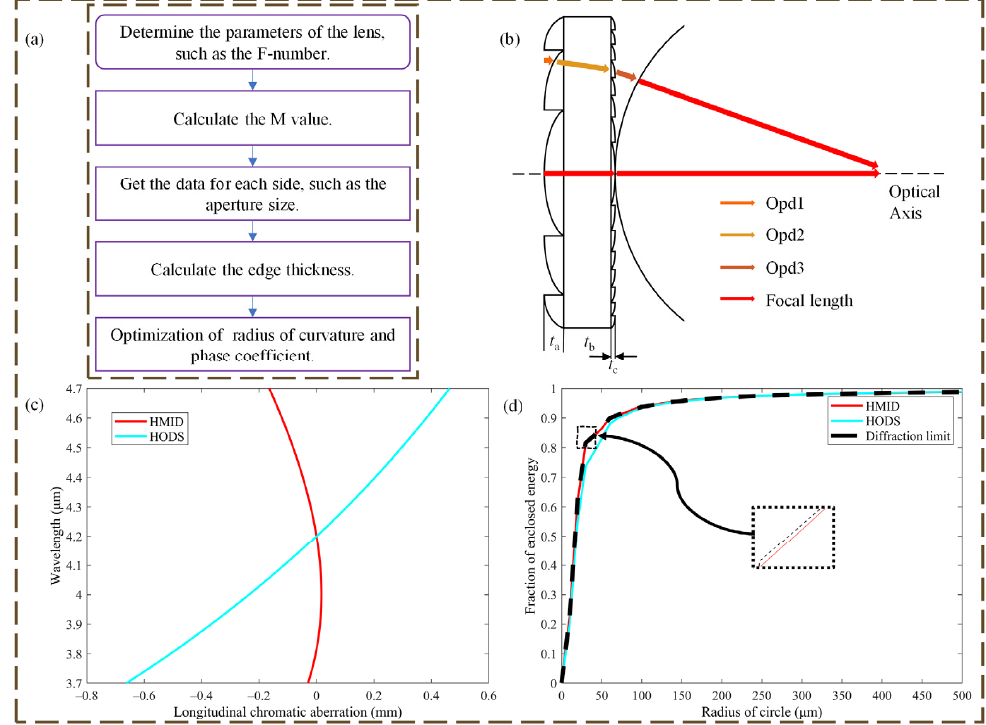
Figure 3. ( a ) Design flow chart of HMID; ( b ) Layout of HMID includes HODS with thickness t a = 0.225 mm and a t b = 4.714 mm germanium substrate with a t c = 1.39 μ m FODS on the back surface. A schematic diagram of the calculation of ray tracing is included; ( c ) LCA comparison of HMID and HODS, where the maximum reduction is 30 times; ( d ) Comparison of encircled energy.